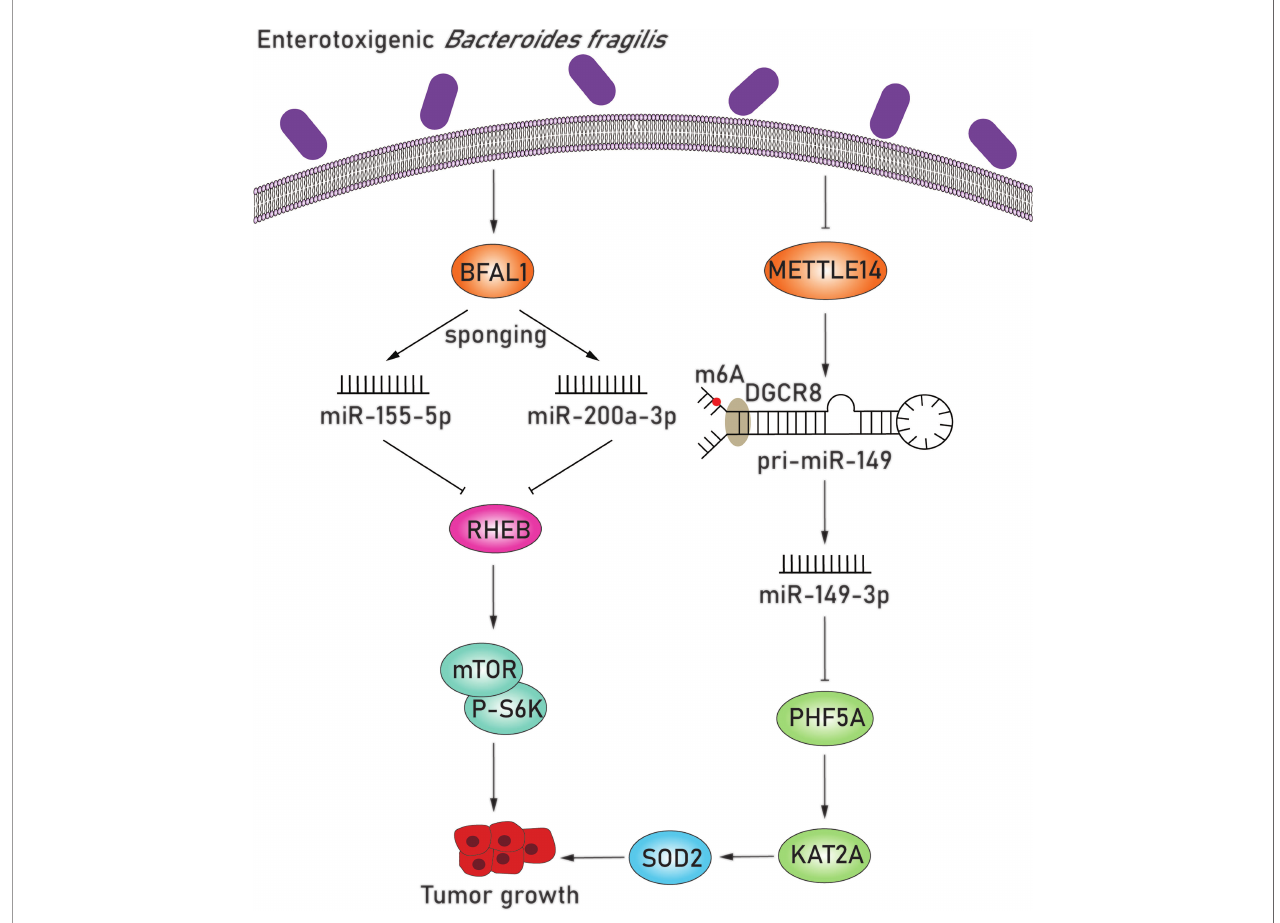
FIGURE 4 | ETBF induces tumor growth by downregulating miR-155-5p, miR-200a-3p, and miR-149-3p. BFAL1 was upregulated in ETBF-infected CRC cells and subsequently decreased the levels of miR-155-5p and miR-200a-3p, which attenuated their suppressive function on target RHEB mRNA expression. The downregulated RHEB consequently activates the RHEB/mTOR pathway, thereby mediating ETBF-induced tumor growth. miR-149-3p is also signi fi cantly downregulated in ETBF-infected CRC cells. Regulation of miR-149-3p was attributed to METTL14-dependent m6A modi fi cation via modifying pri-miRNA splicing. In ETBF-infected CRC cells, METTL14 was downregulated so that the level of miR-149-3p was reduced, which further upregulated target PHF5A. The overexpression of PHF5A upregulated the target mRNA level of KAT2A in CRC cells, which can upregulate SOD2 via directly binding to the promoter region of SOD2. More importantly, the overexpression of SOD2 is relevant to poor clinical outcomes in gastric cancer, and SOD2 may promote intestinal in fl ammation and